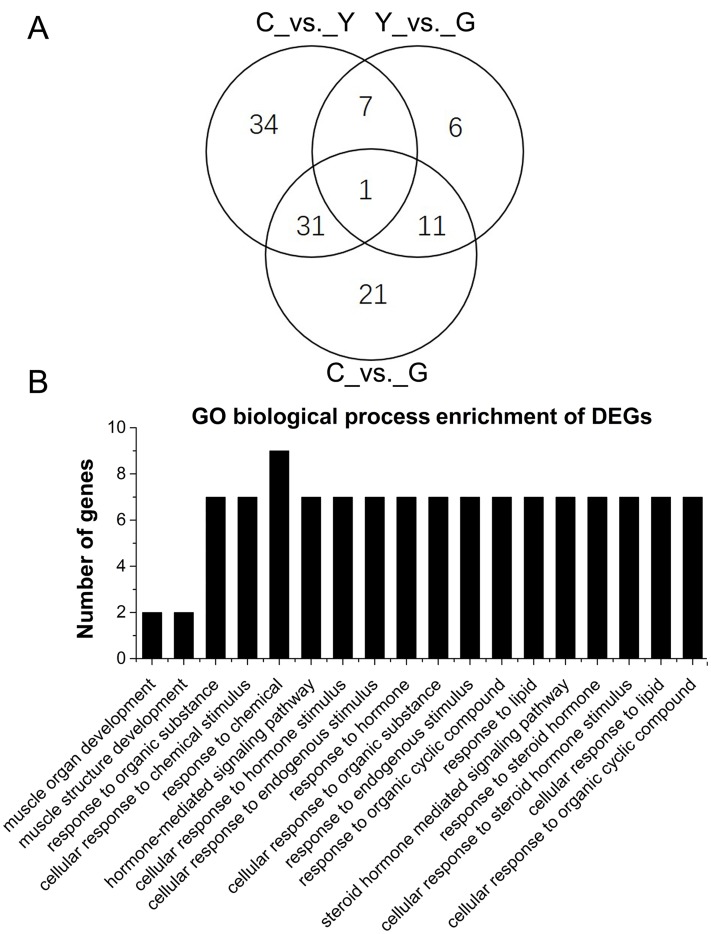
Distribution of differentially expressed genes (DEGs) of goat longissimus dorsi muscle at different postnatal stages.A. Distribution of differentially expressed genes. C_vs._G, the differentially expressed genes in the adult samples (C) compared with the kid (G) samples. C_vs._Y, the DEGs in the “C” samples compared with the youth (Y) samples. Y_vs._G, the DEGs in the group Y samples compared with the group G samples. B. The GO biological process enrichment of defined Unigenes. Significance level was P<0.05.